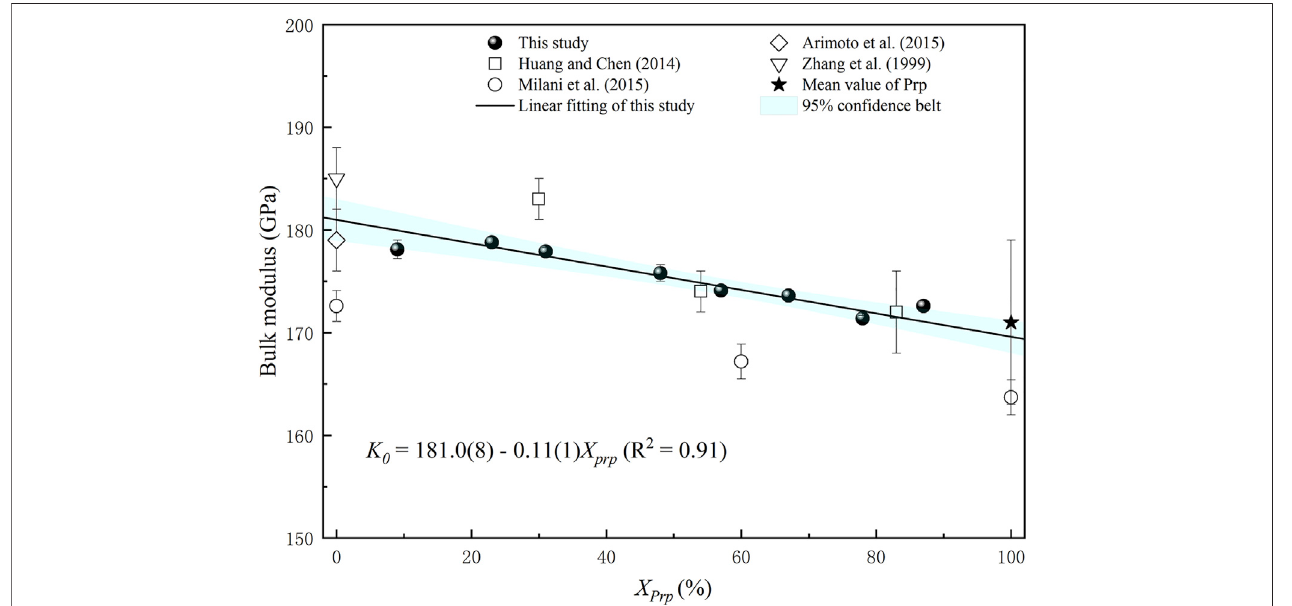
FIGURE 3 | Bulk moduli of pyrope-almandine solid solution garnets as a function of pyrope content .